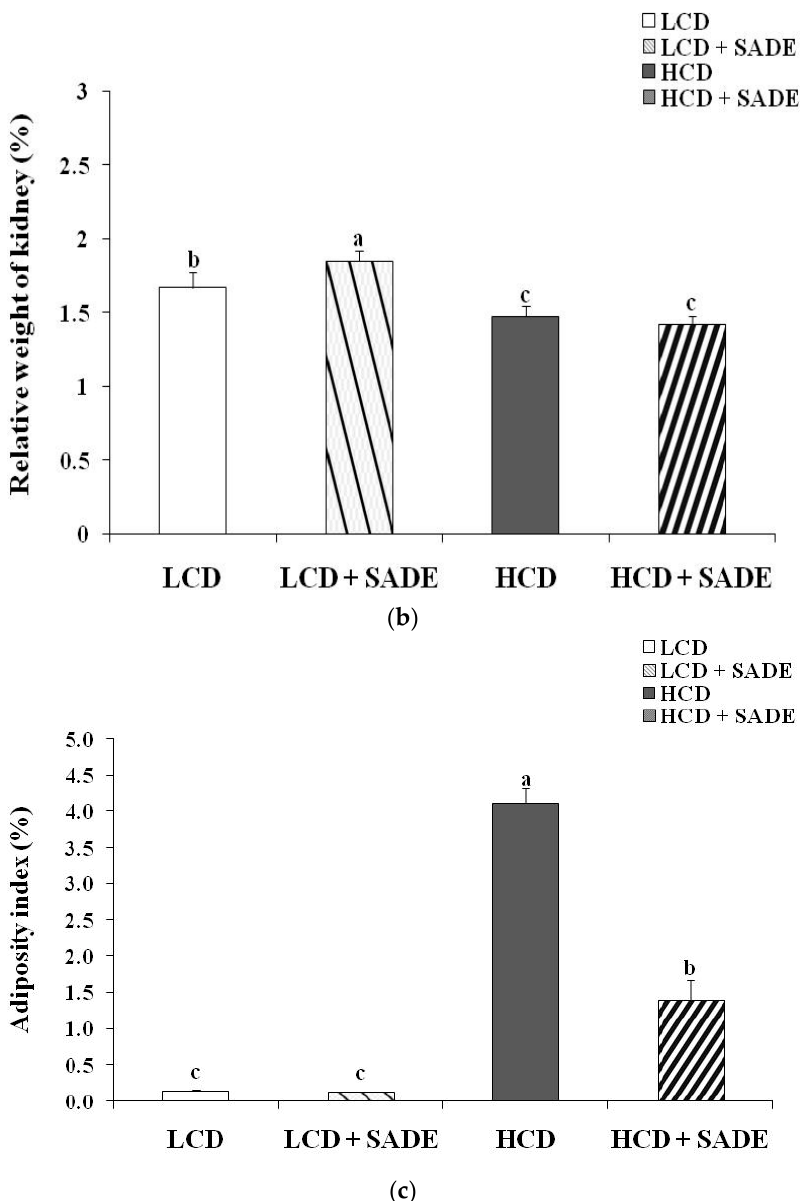
Figure 4. ( a ) Effect of SADE on the relative weight of the liver in P. obesus measured on day 120 in the different animal groups. LCD: animal group fed with natural low-calorie vegetable diet, LCD + SADE: control treated with S. arabica decocted, HCD: rats fed with high-calorie diet and HCD + SADE: rats fed with high-calorie diet treated with S. arabica decocted extract. Results are presented as means ± SD for ten rats in each group. Means not sharing the same superscript letters (a, b) are significantly different between groups (Tukey’s post hoc test, p < 0.05). “a” denotes the highest value and “b” represents the lowest value. ( b ) Effect of SADE on the relative weight of the kidney in P. obesus measured on day 120 in the different animal groups. LCD: animal group fed with natural low-calorie vegetable diet, LCD + SADE: LCD treated with S. arabica decocted, HCD: rats fed with high-calorie diet and HCD + SADE: rats fed with high-calorie diet treated with S. arabica decocted extract. Results are presented as means ± SD for ten rats in each group. Means not sharing the same superscript letters (a, b, c) are significantly different between groups (Tukey’s post hoc test, p < 0.05). “a” denotes the highest value and “c” represents the lowest value. ( c ) Effect of SADE on the relative weight of adiposity index in P. obesus measured on day 120 in the different animal groups. LCD: animal group fed with natural low-calorie vegetable diet, LCD + SADE: LCD group treated with S. arabica decocted, HCD: rats fed with high-calorie diet and HCD + SADE: rats fed with high-calorie diet treated with S. arabica decocted extract. Results are presented as means ± SD for ten rats in each group. Means not sharing the same superscript letters (a, b, c) are significantly different between